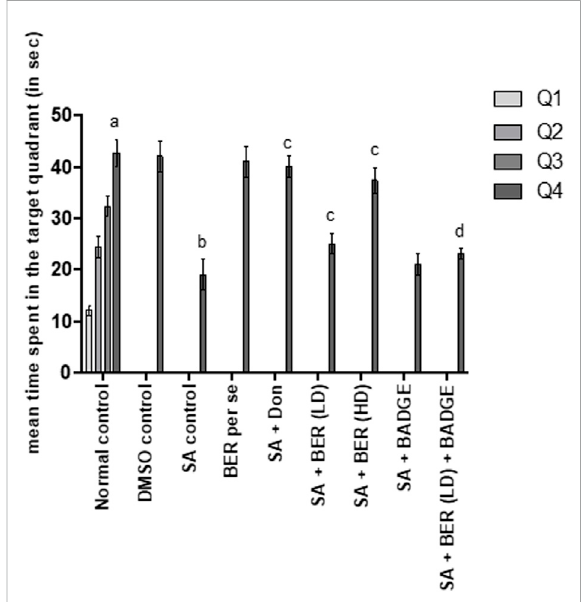
FIGURE 2 Effect of pharmacological interventions on the total time spent in the target quadrant (TSTQ) in seconds using the Morris water maze test. “ DMSO, dimethyl sulfoxide; SA, sodium azide; Don, donepezil; BER, bergenin; BER (LD), bergenin low dose; BER (HD), bergenin high dose; BADGE, Bisphenol A diglycidyl ether ” (Mehra et al., 2015). “ Each group ( n = 6) represents mean ± S.E.M,a= p ˂ 0.05vs.timespentinquadrantoneinnormalcontrol, b = p ˂ 0.05 vs. time spent in the target quadrant in normal control, c = p ˂ 0.05 vs. time spent in the target quadrant in SA control, d = p ˂ 0.05 vs. time spent in target quadrant in SA + BER (LD) treated group ” (Sodhi and Singh, 2013b). One-way ANOVA followed by Bonferroni ’ s multiple range